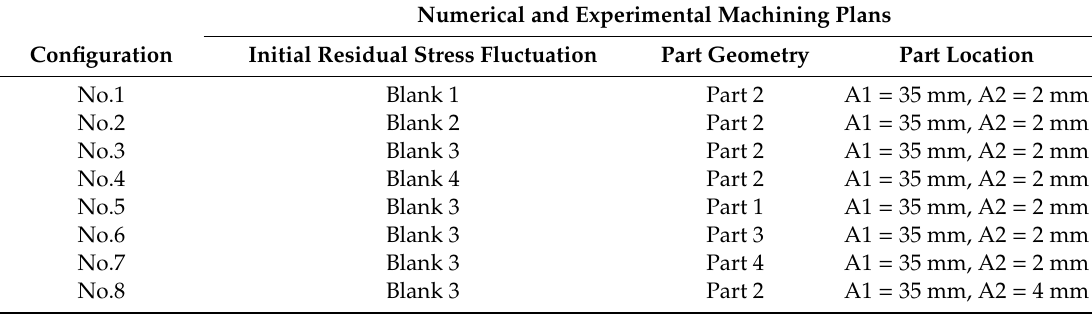
Table 2. The numerical and experimental machining plans.